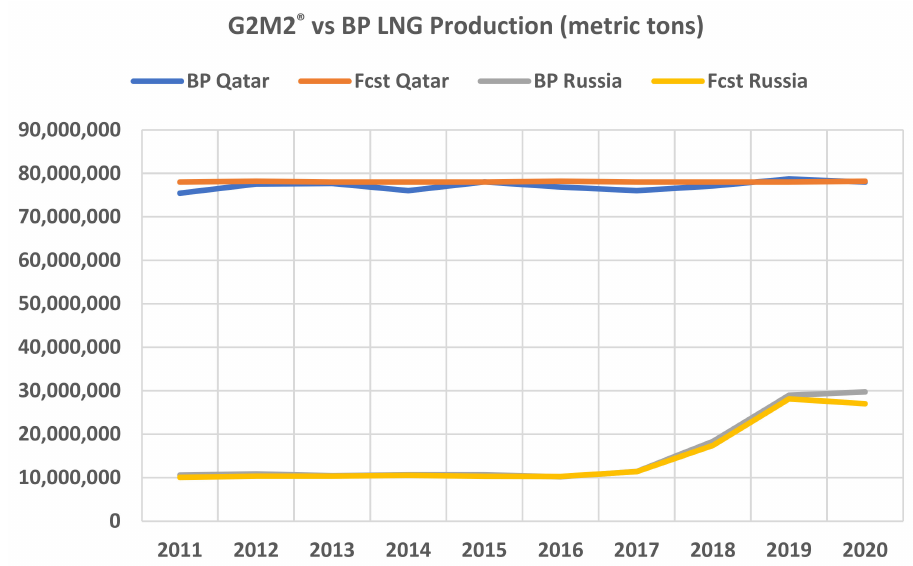
Table A1. Comparison of G2M2 ® forecasted LNG production.